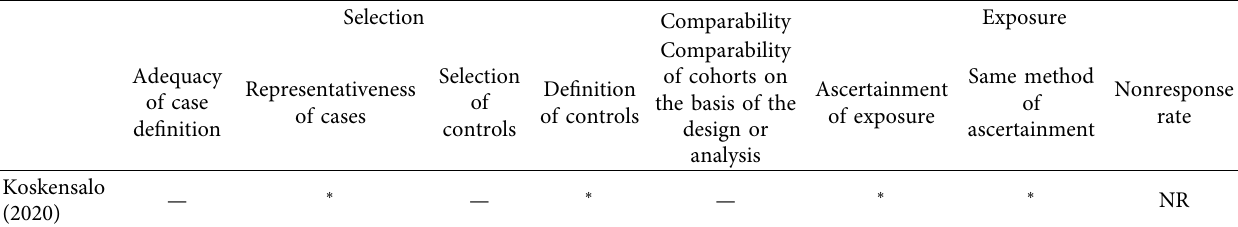
Table 5: Risk of bias of case-control study using the Newcastle-Ottawa scale.